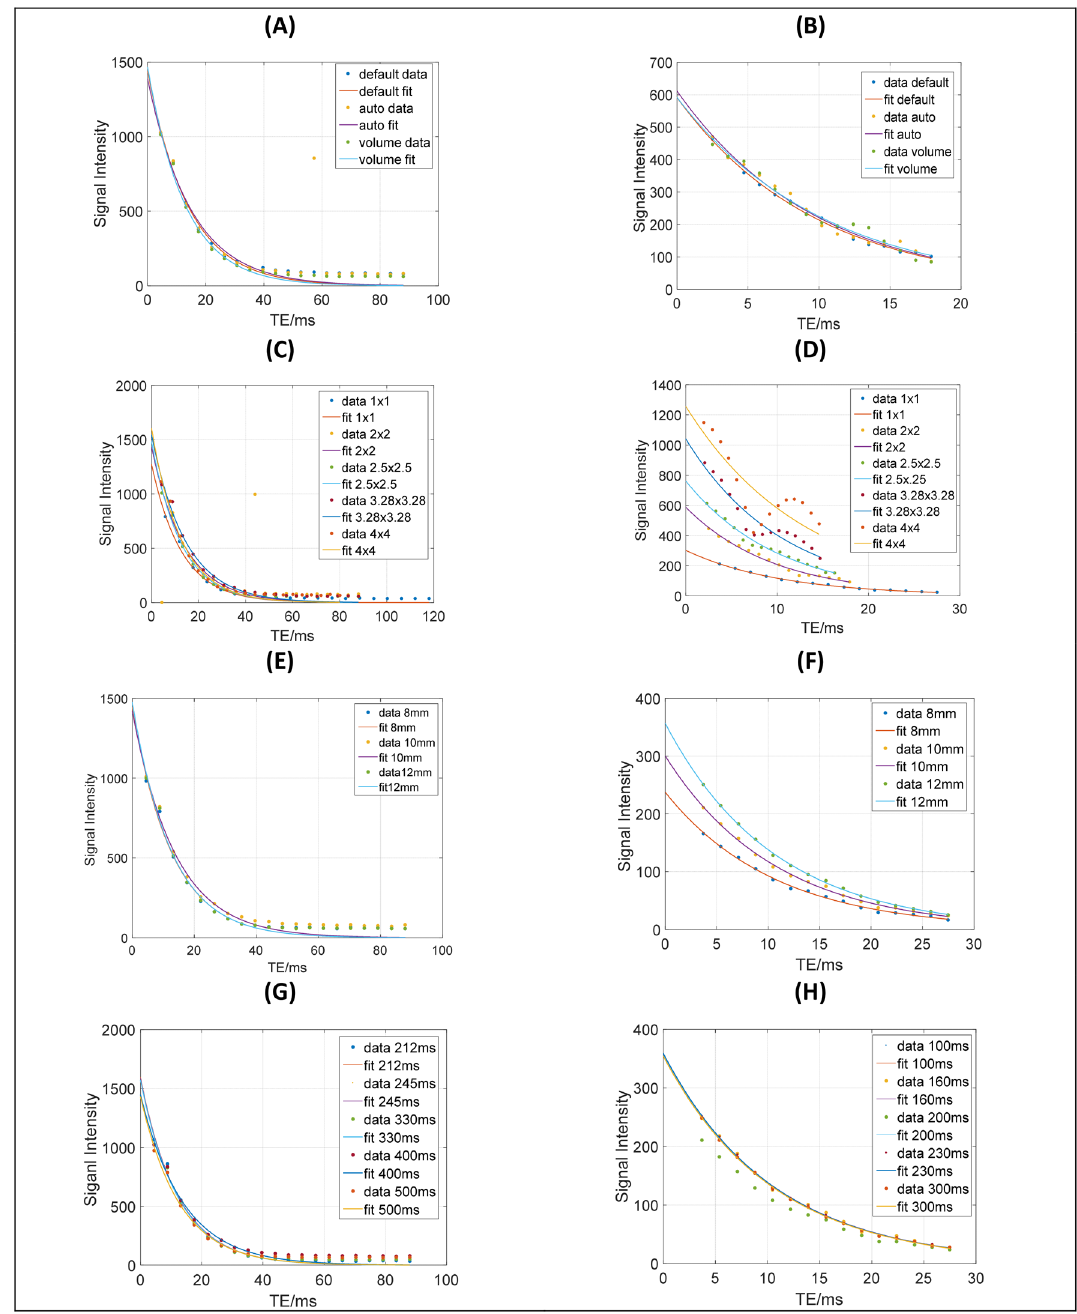
Figure 1. Decay curves of the 2% Gd concentration for T2 and T2* sequences, respectively, using; the three shims ( A , B ), Five different pixel sizes ( C , D ), three slice thickness ( E , F ) and five TR values ( G , H